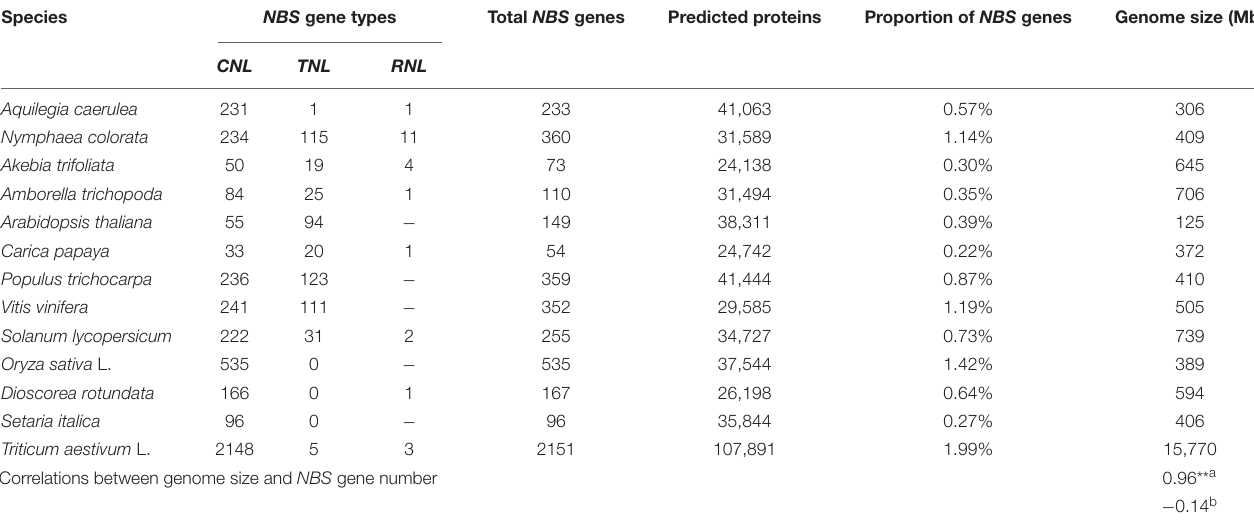
TABLE 1 | The numbers of predicted NBS genes in sequenced plant genomes.